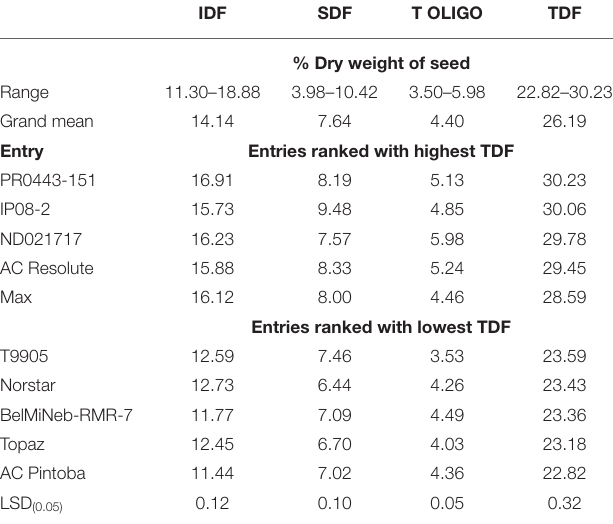
TABLE 1 | Range, grand means, and the five entries ranked highest and lowest for total dietary fiber (TDF) content and their respective components, insoluble dietary fiber (IDF), soluble dietary fiber (SDF) and total oligosaccharide (T OLIGO) content among entries (275) grown in Colorado.